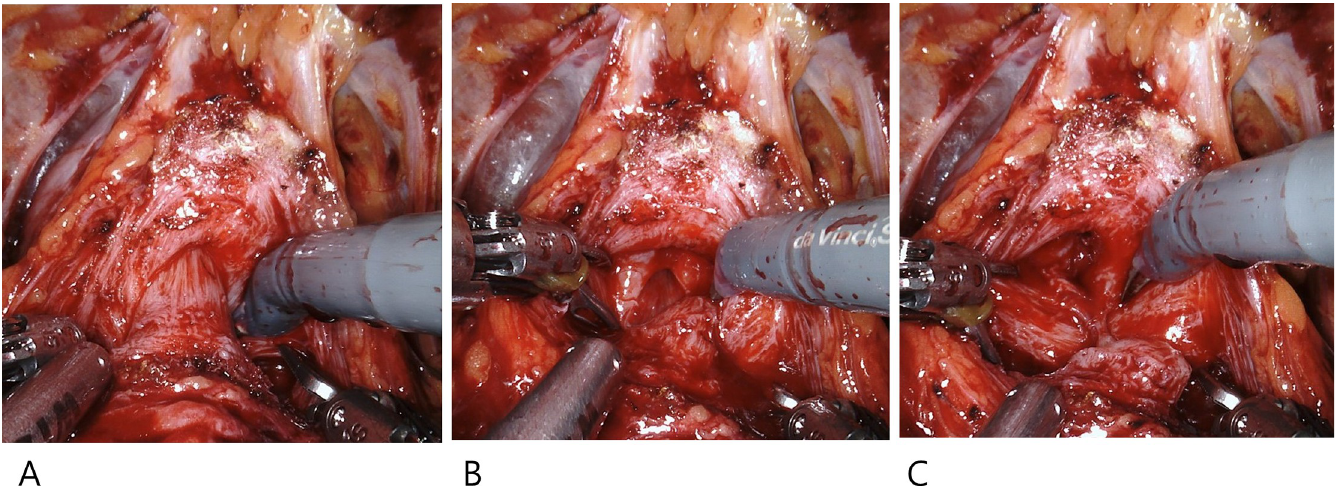
Fig 1. Bladder neck preservation and proximal urethral